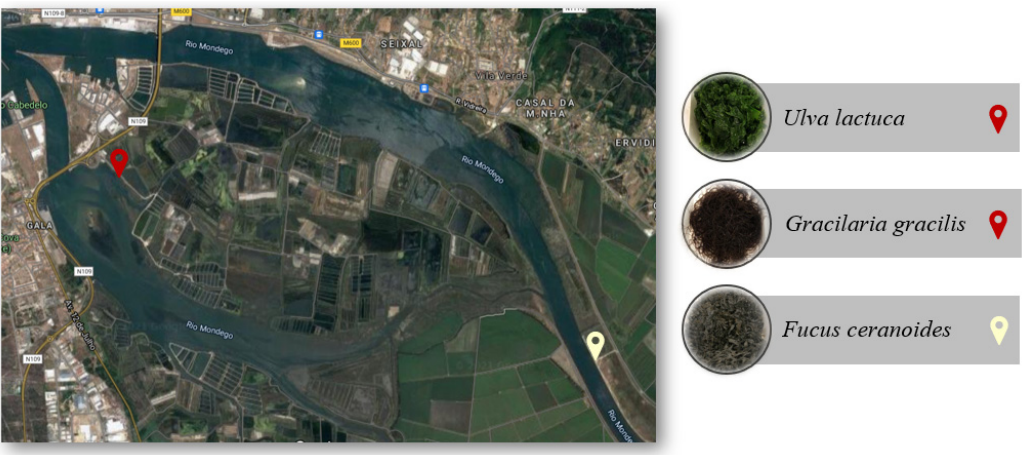
Figure 2. Location of seaweed sampling sites (U. lactuca and G. gracilis , harvested from the same site, and F. ceranoides ) at Mondego estuary, Figueira da Foz, Portugal. Copyright: Google maps.